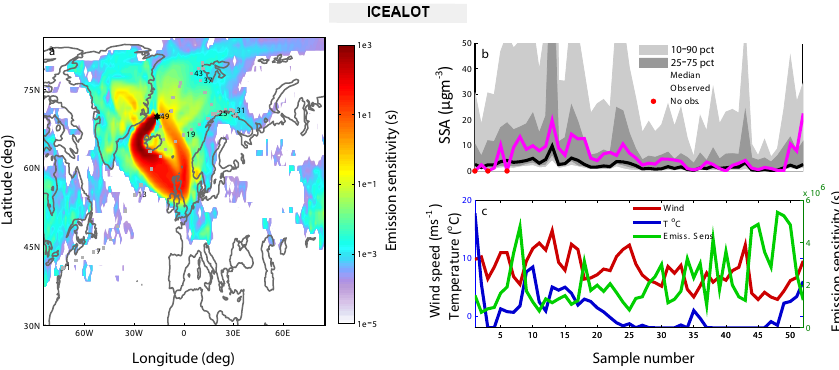
Fig. 5. (a) FLEXPART footprint emission sensitivity for the 10h long 49th observation from ICEALOT, taken north of Iceland (black star) on 24 April 2008. The color scale indicates where, at any time during the past 20 days, the observation is sensitive to emission. (b) SSA concentration time series for the NOAA cruise ICEALOT. The solid pink line shows the observed PM 10 concentrations along the ship track, for samples taken over durations of 8 to 24h. The black line is the FLEXPART-simulated SSA concentration, averaged over 22 different source functions. The dark gray area shows the interquartile range (25–75%) of all simulated concentrations, while the light gray area shows the 10–90% range. (c) The mean temperature, wind speed and total footprint emission sensitivity over the ocean surface of the air mass before being sampled (marine footprint) for all the ICEALOT observations. The wind and temperature means are weighted by the footprint emission